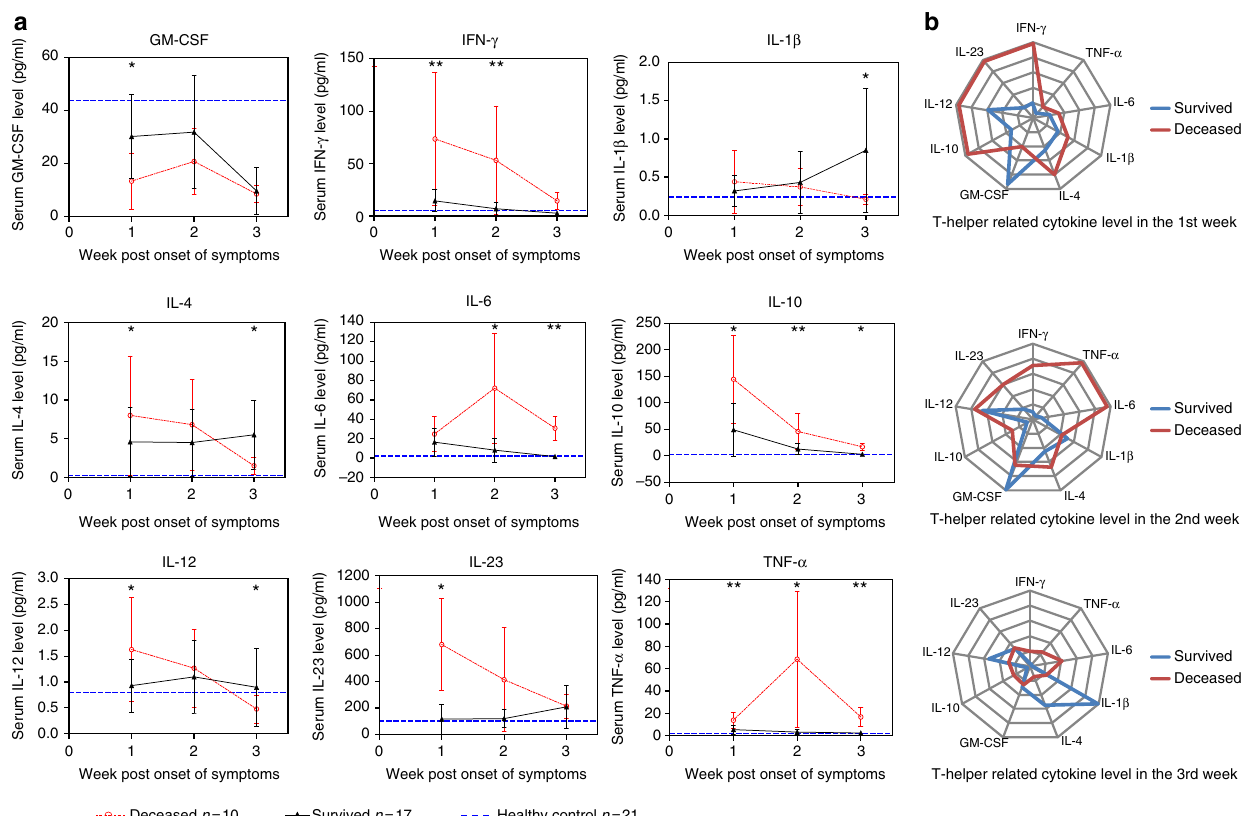
Fig. 8 Dynamic modulation of serum T-helper-related cytokines in selected SFTS patients. a Kinetics of serum cytokines in the 3-week period post symptom onset and comparison of the level of each cytokine between survived and deceased patients. Black triangles, red circles and blue horizontal lines represent means of survived, deceased and HC group, respectively. Statistic analysis was conducted between the survived and deceased group. * p < 0.05, ** p < 0.005, NS = no signi fi cance. b Radar plots comparing regulatory pro fi les of the cytokines between the survived and deceased groups are generated from a to indicate the dynamic changes of cytokines during the three-week clinical course. The radar periphery represents higher values of the cytokine expression. Error bar represents the standard